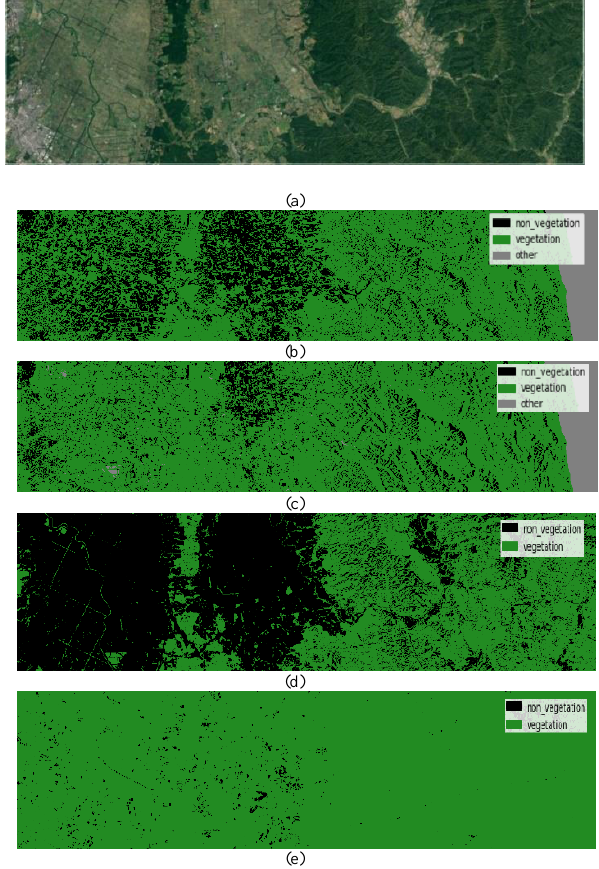
(e) Figure 5: Classification results on Sentinel-1 and Sentinel-2 data sets; a: RGB image; b: 1D CNN Sentinel-1 data set; c: RF Sentinel-1 data set; d: 1D CNN Sentinel-2 data set; e: RF Sentinel-2 data set.